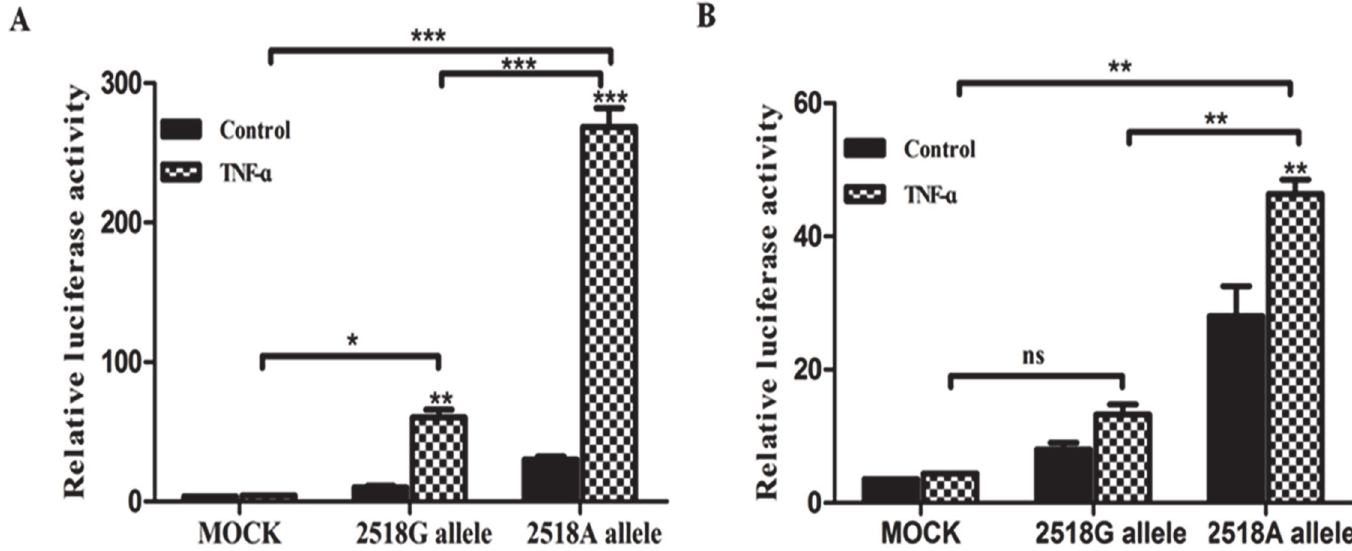
Fig 2. Two constructs were transiently transfected into 3T3L1 (A), and OVCAR3 (B) cell lines, respectively. (A) TNF- α induced a significant increase in luciferase activity from all the constructs. Moreover, the transcription activity of AA constructs was approximately 5 fold greater than the activity of GG constructs in 3T3L1 cells. (B) The OVCAR3 cells transfected with -2518A allele had a 3 fold increase in reporter gene activity as compared with the -2518G allele. Luciferase activity of each construct was normalized against internal control of Renilla luciferase. Each experiment was performed three times. Data indicate a mean value with SEM from 3 independent experiments. * P < 0.05, ** P < 0.01, *** P < 0.001. ns, not significant. Data were analyzed by a two- way analysis of variance, and significant differences were determined by Tukey-Kramer